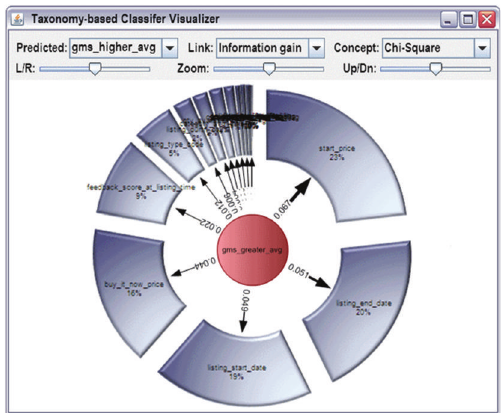
Figure 11: Visualization of attribute-to-class information at abstract level (high